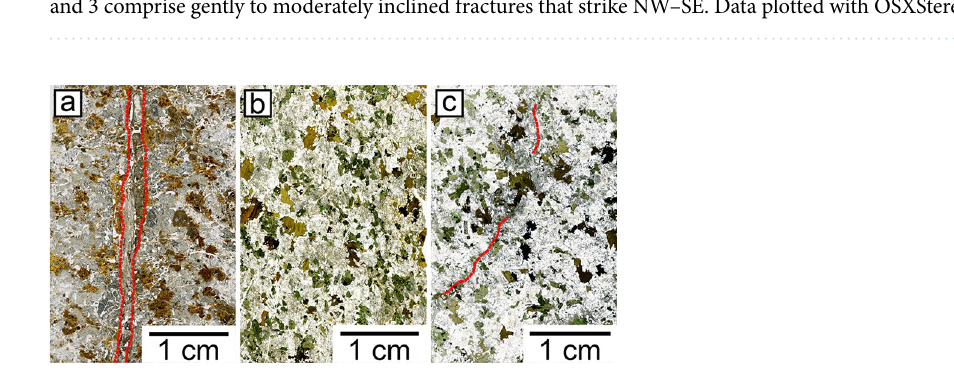
Figure 4. Thin sections of ( a ) The strongest degree of weathering found in a sample from a nearby soil pit showing a carbonate vein delineated in red (sample depth: 1.74 m). ( b ) Moderately weathered sample from zone C (average depth: 11.8 m). ( c ) Bedrock sample (zone VI) with a carbonate veinlet (average depth: 82.6